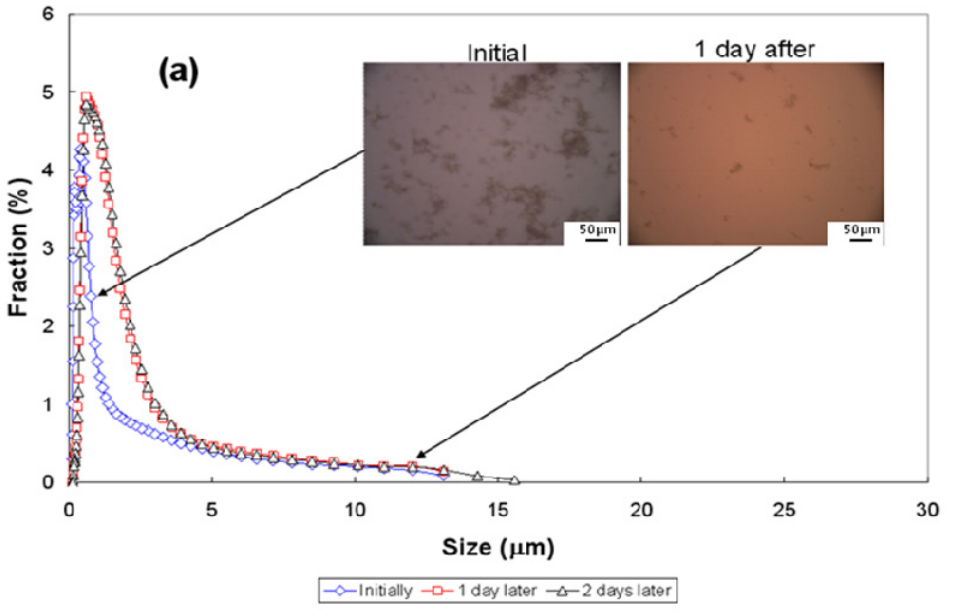
Figure 7. Particle-size distribution of Kaofine at pH~7. ( a ) 1MLB; ( b )